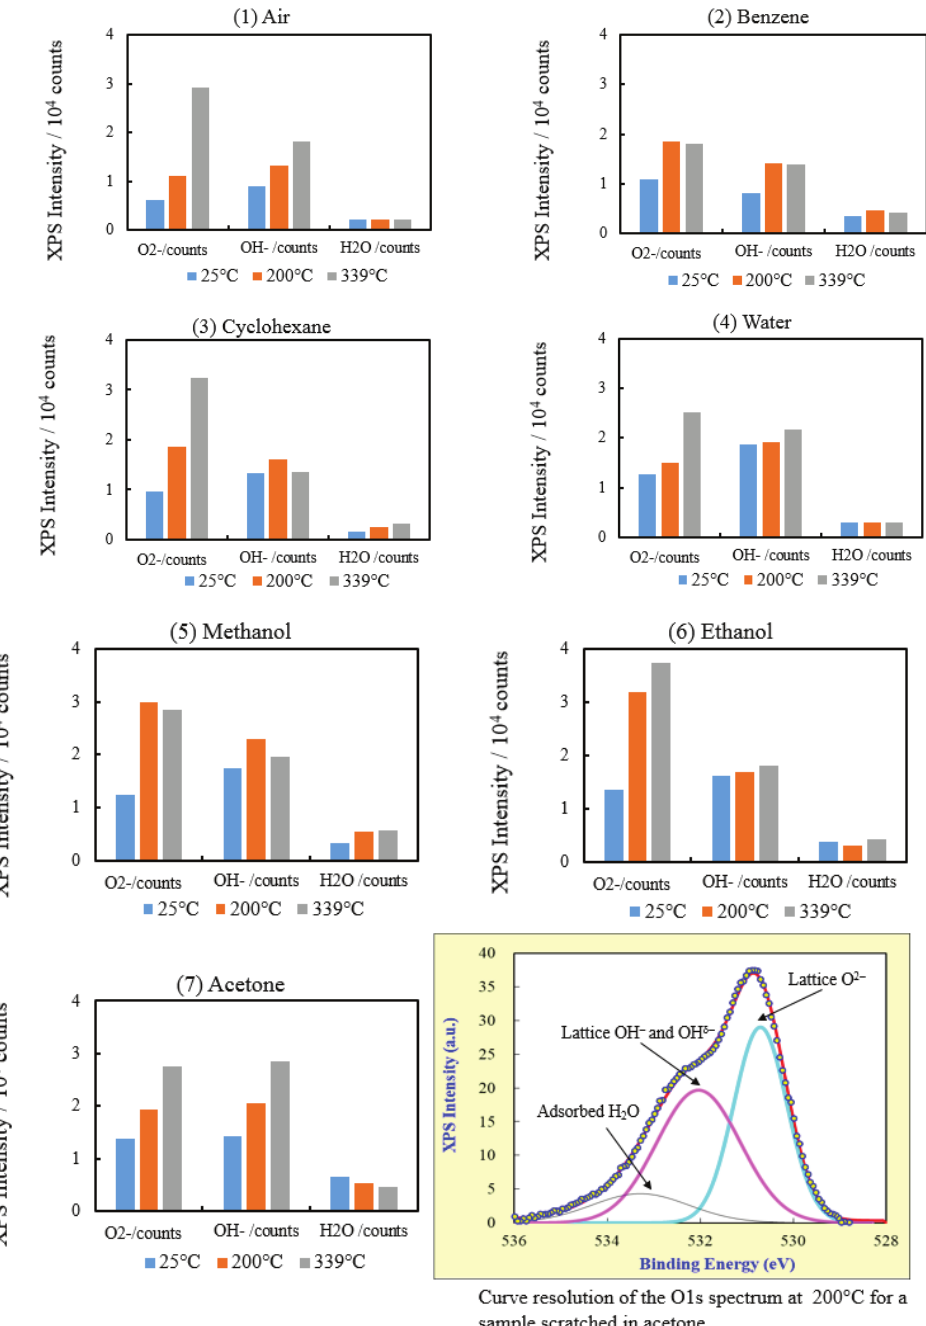
Figure 5. Temperature dependence of XPS intensity of three components of O 2 − , OH − , and H 2 O of the O 1 s spectrum of scratched real iron surfaces on different environments: (1) air, (2) benzene, (3) cyclohexane, (4) water, (5) methanol, (6) ethanol, and (7) acetone. A typical example of the curve resolution of the O 1 s spectrum for acetone is also shown. Table 3. Temperature dependence of binding energies of three components of O (cid:16094)(cid:16089) , OH − and OH (cid:904) − , and H 2 O in the O 1 s spectrum for iron surfaces scratched in different environments.